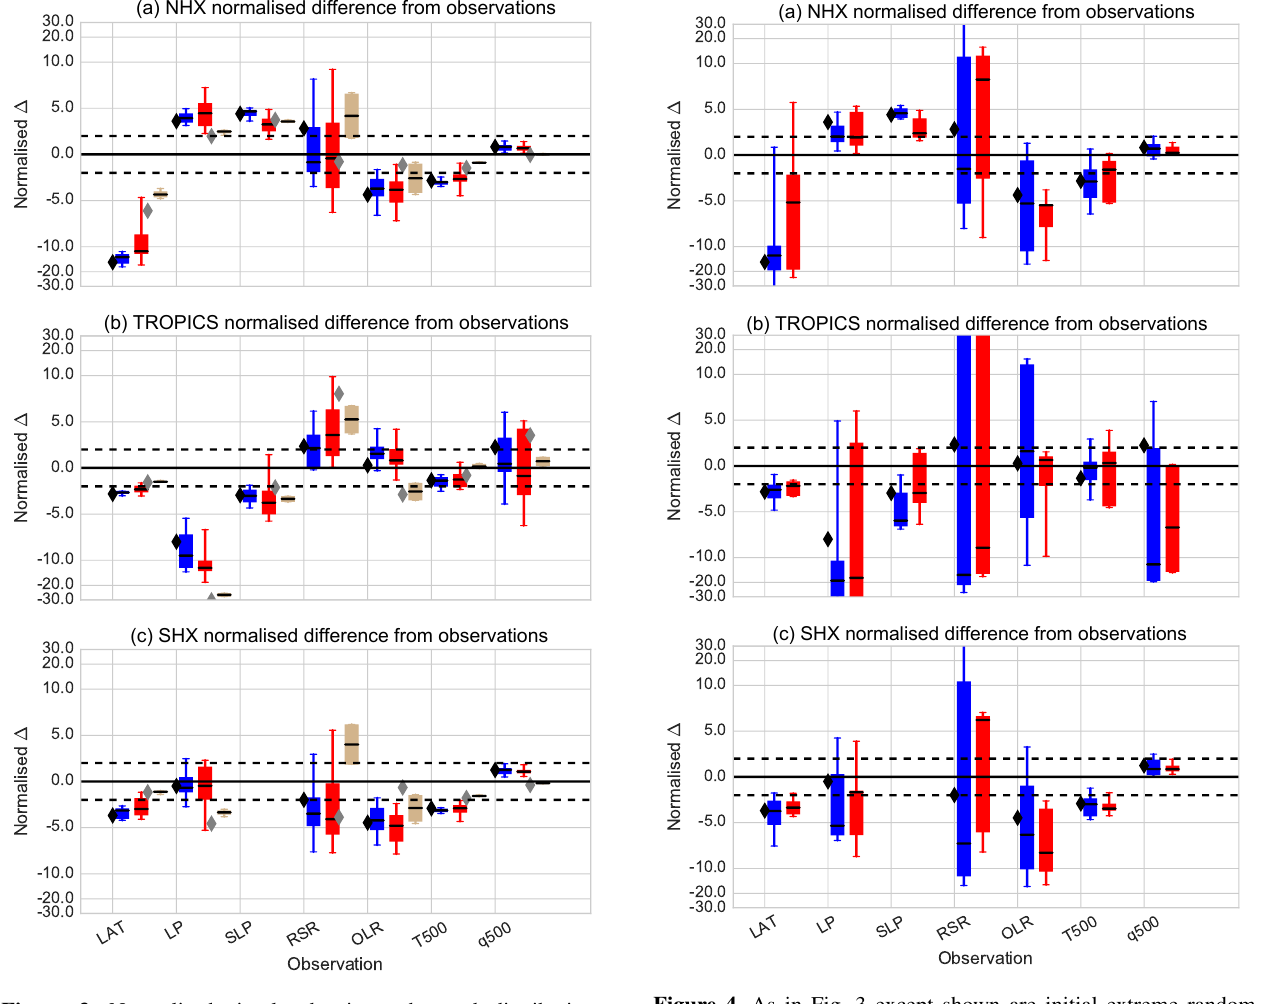
Figure 3. Normalised simulated minus observed distributions ( y axis) for 7- (blue) and 14-parameter (red) cases. Top panel (a) is Northern Hemisphere extra-tropics, middle (b) tropics and lower Southern Hemisphere extra-tropics. Boxes and whiskers as in Fig. 2, with observations on x axis. Also shown are the optimised HadAM3P (light brown) cases and the standard HadAM3 (black di- amonds) and HadAM3P (grey diamonds) values. All differences are normalised by the square root of the diagonal elements of C . The dashed lines show ± 2. The scale is linear between 5 and − 5 and logarithmic outside that range.